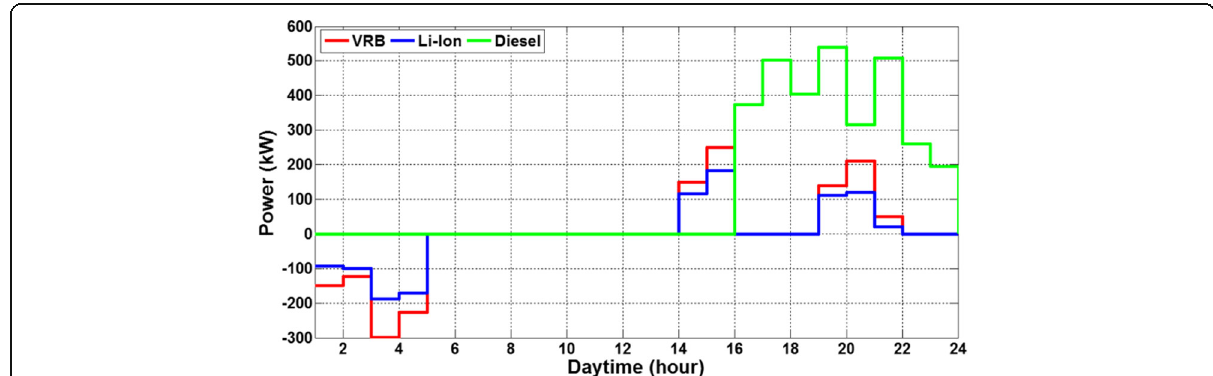
Fig. 14 Energy resources dynamic scheduling using GA in isolated operation